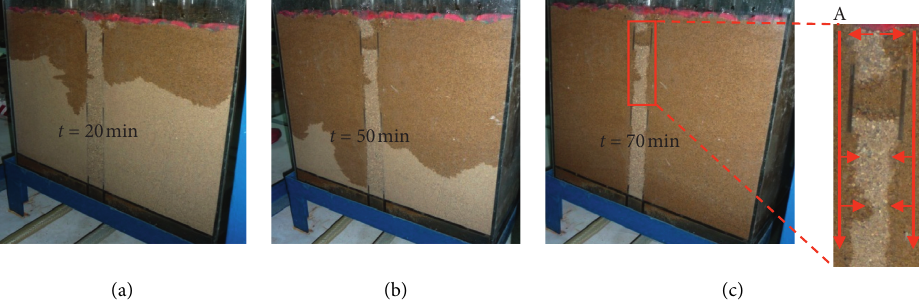
Figure 4: Vertical infiltration of water into an analog fracture-matrix system. A is the flow direction of the partial enlargement of main plot at